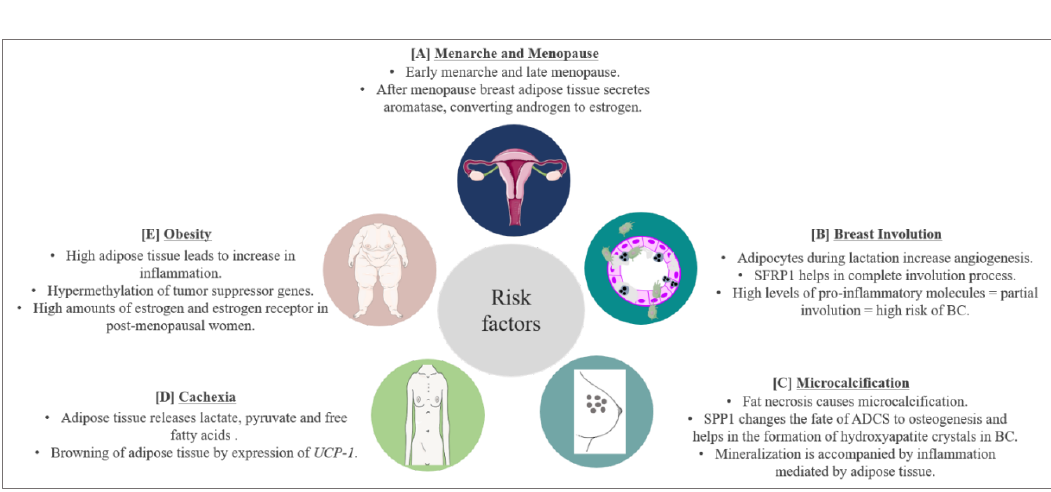
Figure 3. BC risk factors and prognostic factors and the role of adipose tissue. ( A ) Early menarche and late menopause increase the risk of BC by increasing the exposure of breast cells to estrogen hormones. Breast adipose tissue secretes aromatase which converts androgen to estrogen further complicating the scenario. ( B ) Breast adipose tissue secretes SFRP1 which helps in post-lactation involution age-related breast involution. Involution involves the inflammation process leading to apoptosis of epithelial cells. High levels of pro-inflammatory molecules secreted by breast adipose tissue lead to partial involution which increases the risk of BC. ( C ) Microcalcification is a predisposing factor for BC. Microcalcifications due to fat necrosis resemble malignant microcalcifications further complexifying prognosis of BC. Furthermore, SPP1 secreted by breast adipose tissue changes the fate of adipose derived stem cells (ADSC) to osteogenesis, increasing BC risk. Moreover, breast adipose tissue increases the inflammatory process accompanying mineralization. ( D ) During BC progression, BC cells signal lipolysis of surrounding adipose tissue to meet the energy requirement of BC. Adipose tissue releases lactate, pyruvate and free fatty acids. WAT also starts to express UCP-1, thereby trans differentiating to BAT and exhausting the energy source of the body. This leads to cachexia and eventually death. Around 30–50% of cancer-associated deaths are due to cachexia. ( E ) Obesity is a worldwide problem and known to increase BC risk. High adipose tissue increases the inflammatory process and hypermethylation (resulting in inhibition) of tumor suppressor genes. Obesity also increases the expression of estrogen and estrogen receptors in postmenopausal women, enhancing the risk of BC.